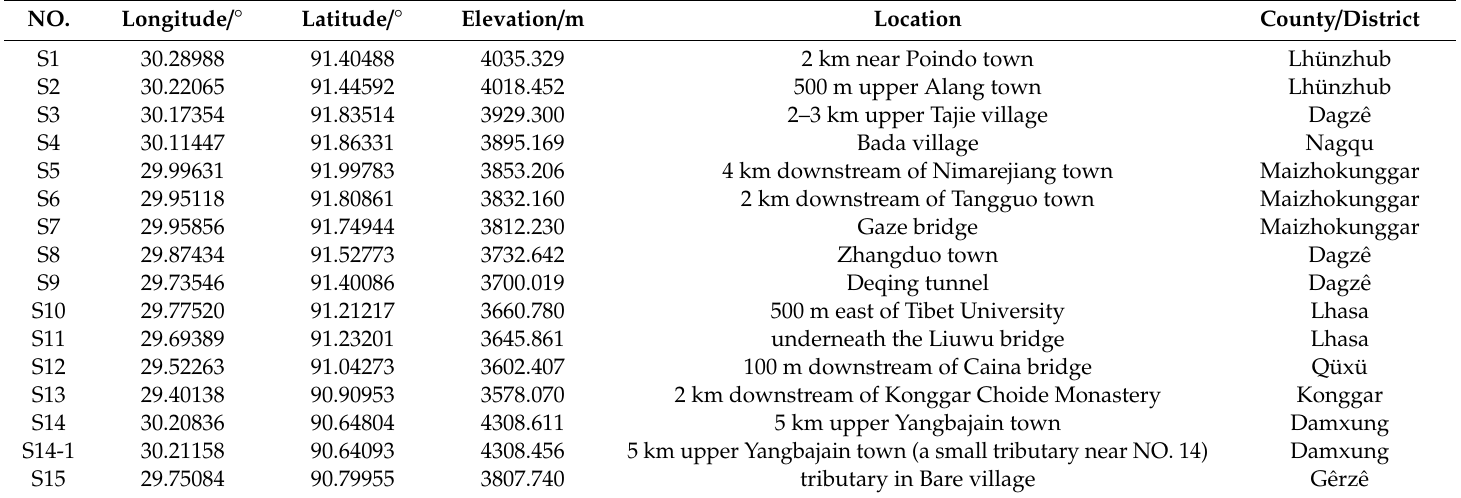
Table 1. Information of the sampling sites, including longitude, latitude, elevation, location, and the counties / districts these sites belong to.